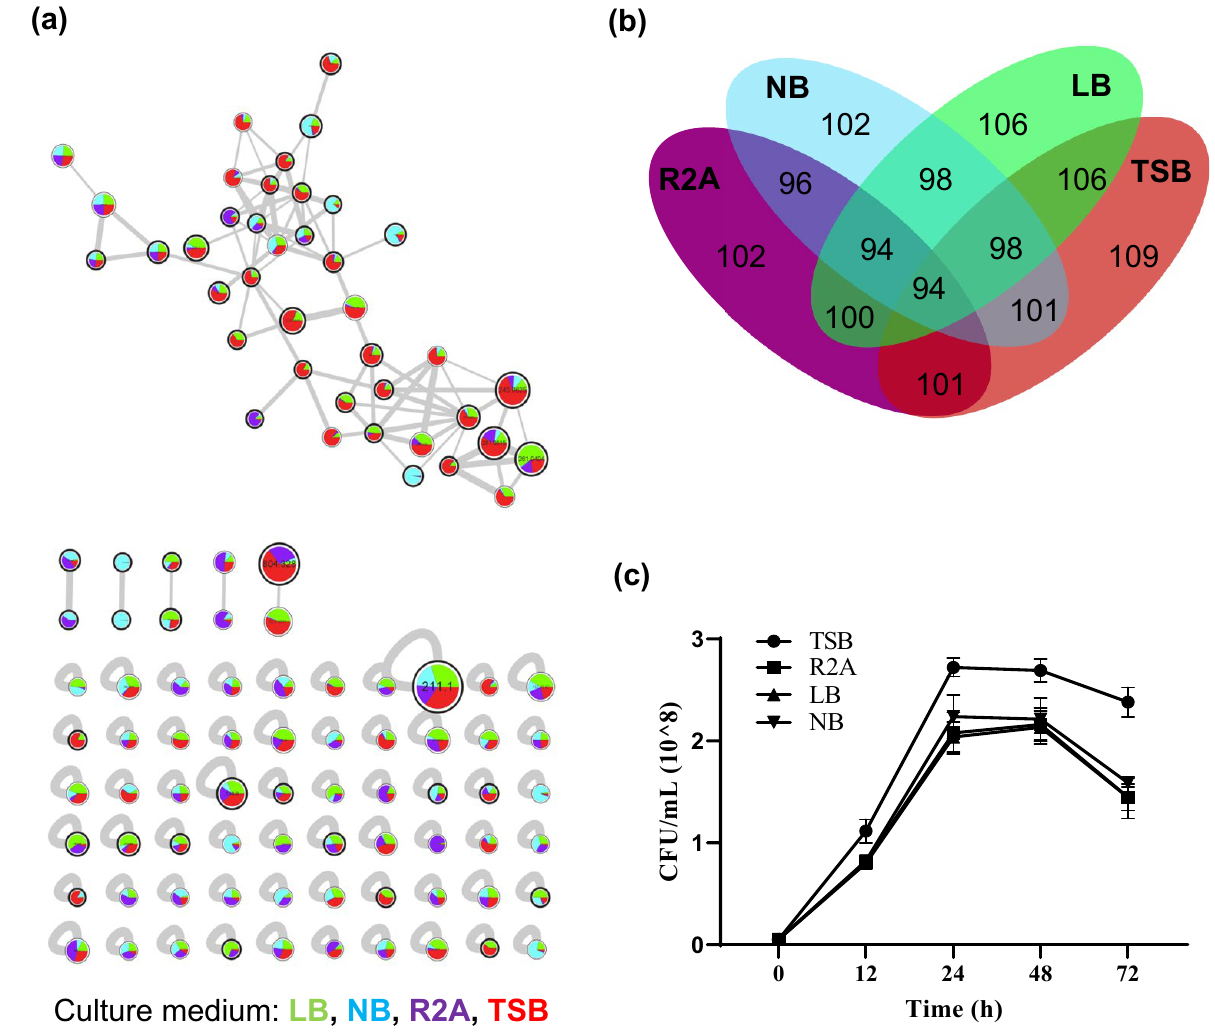
Figure 1. Metabolomics analysis of Peribacillus frigoritolerans BE93 grown in different culture media. ( a ) Feature-based molecular networking (FBMN) of the detected secondary metabolites from BE93 culture extracts. Each node represents one fragmentation spectrum from a detected compound, node size represents the summed ion intensity from all samples, edge thickness indicates the relative similarity of the tandem mass (MS/MS) data between nodes, and the pie charts indicate the relative abundance of each compound from the different samples. Nodes having a putative library match are outlined in black. Colors represent the culture medium. ( b ) Venn diagram showing the counts and distributions of nodes among the different culture media. ( c ) Growth curve of BE93 in different culture